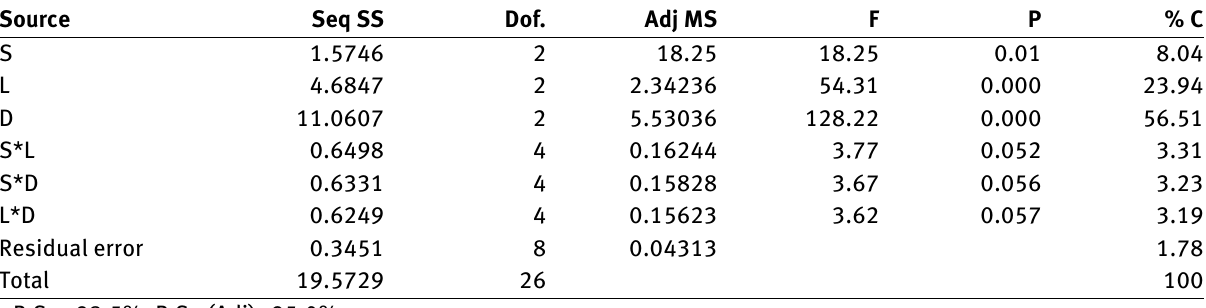
Table 5: ANOVA analysis of mono-composite (Al2219+8% B4C)